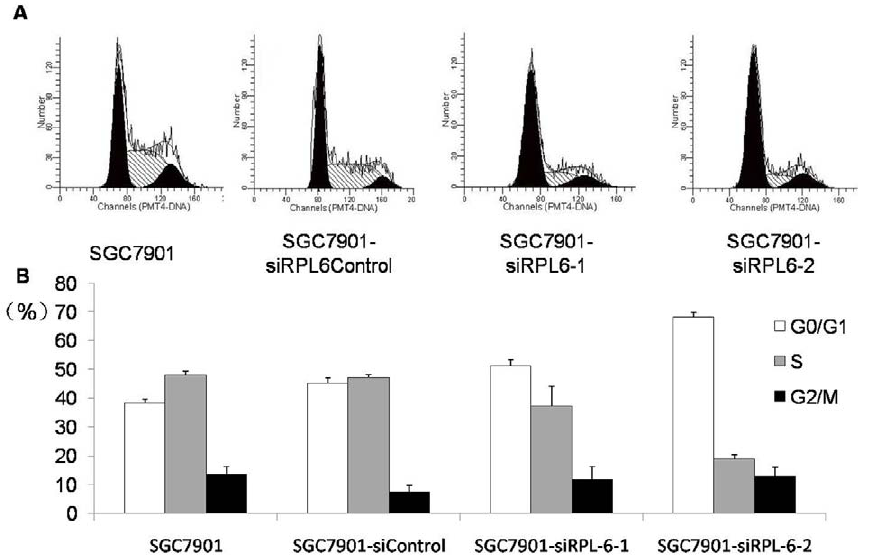
Figure 5. Cell cycle analysis of SGC7901 cells and its derivates. A. SGC7901 and its derivates in log phase were harvested and subjected to cell cycle analysis. The cell cycle phase distribution was evaluated by FACS. Shown are representative images of four separate experiments. B. Cell cycle distribution of SGC7901, SGC7901-siRPL6-1, SGC7901-siRPL6-2 and SGC7901-siRPL6Control cell lines. The cell cycle distribution was calculated and expressed as mean 6 SD of four separate experiments. p , 0.05.